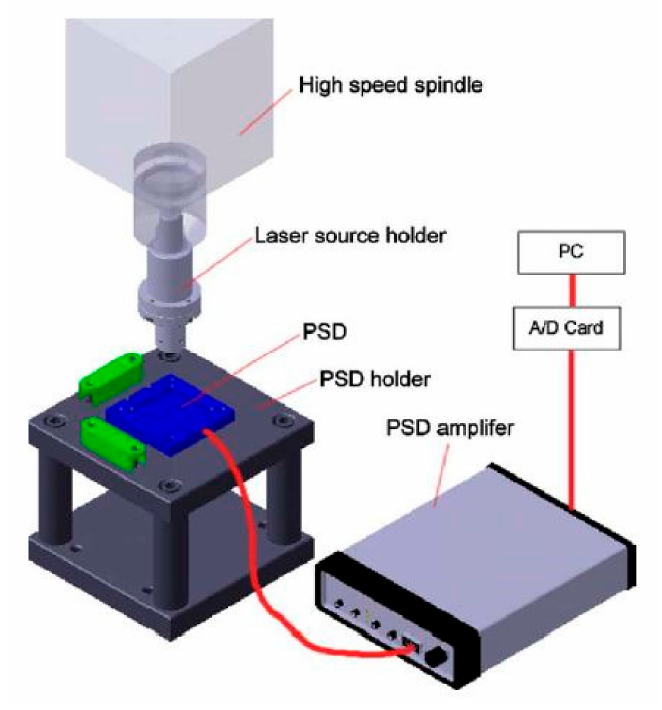
Figure 27. System for measuring high-speed spindles [29].